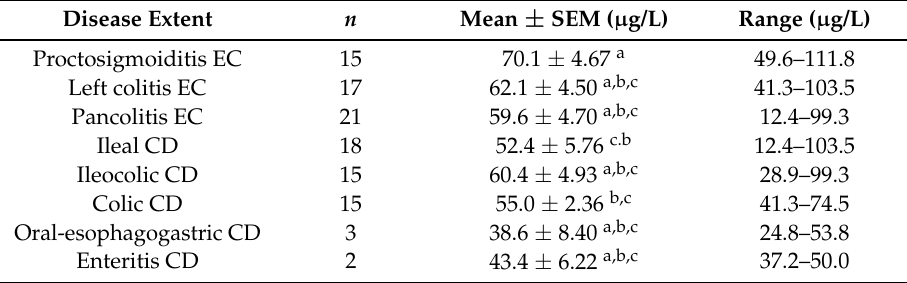
Table 6. Serum Se concentrations of IBD patients as a function of disease extent.